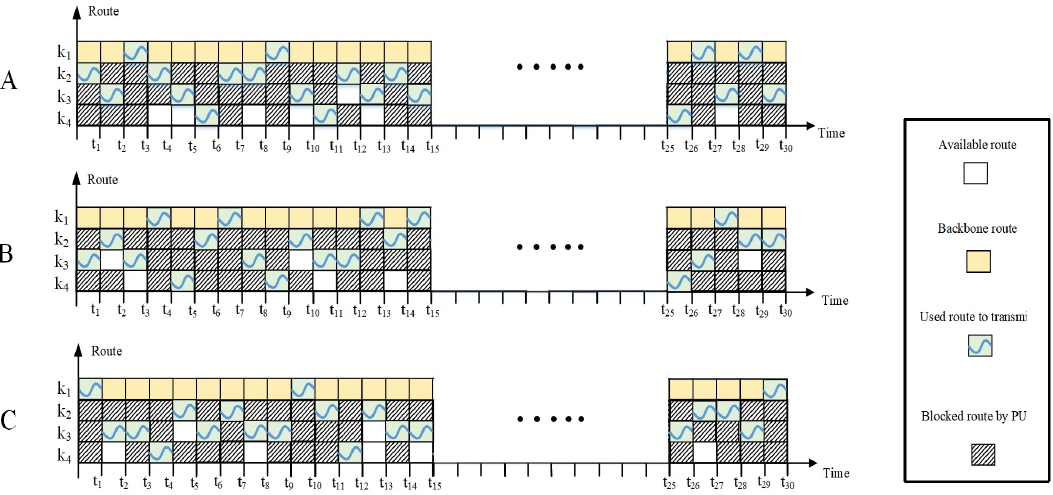
Figure 4. Random appearance of PU activities in D2D routes in three transmission cycles ( A – C ).